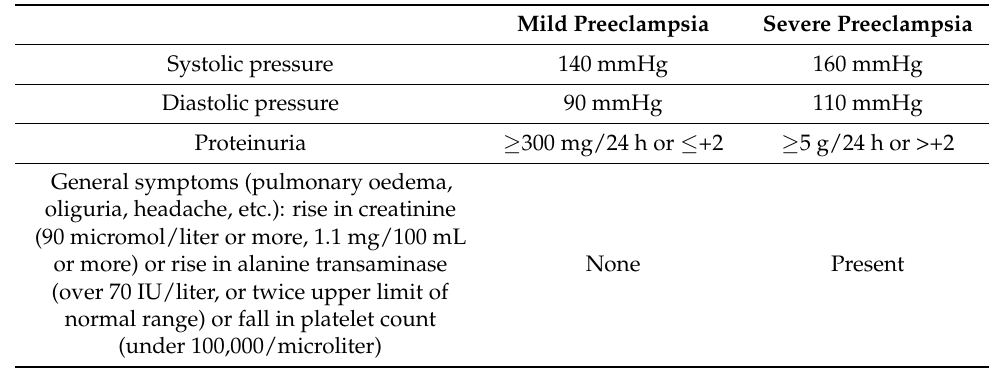
Table 1. Division of symptoms of mild and severe